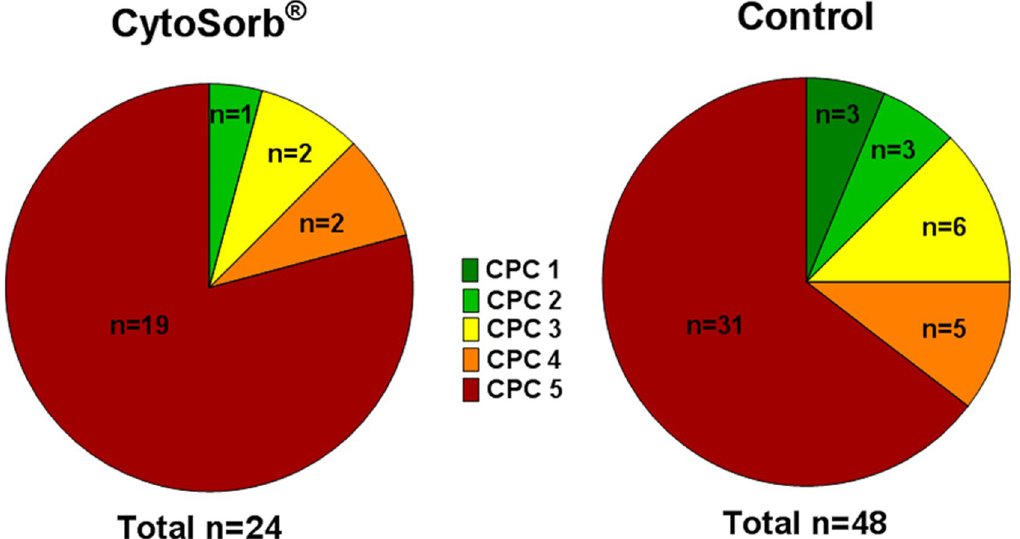
Fig 2. 30-day-neurological outcome of survivors in the CytoSorb 1 and matched control group.